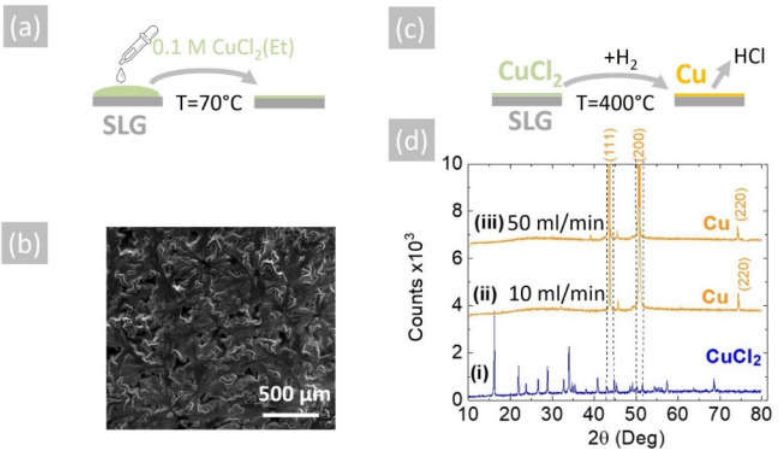
Figure 4. ( a ) Schematic illustration of drop-casting a 0.1 M CuCl 2 (Et) solution on SLG at 70 °C to aid the evaporation of the ethanol; ( b ) SEM image of the CuCl 2 on SLG, which had a light green color; ( c ) schematic of conversion of CuCl 2 into Cu under H 2 at 400 °C; ( d ) XRD of (i) CuCl 2 as-deposited on SLG, (ii) Cu obtained from CuCl 2 under 10 mL/min H 2 and (iii) 50 mL/min H 2 . All of the CuCl 2 peaks vanish, and the peaks belonging to Cu do not overlap with those of CuCl 2 , as shown with the aid of the broken vertical lines.